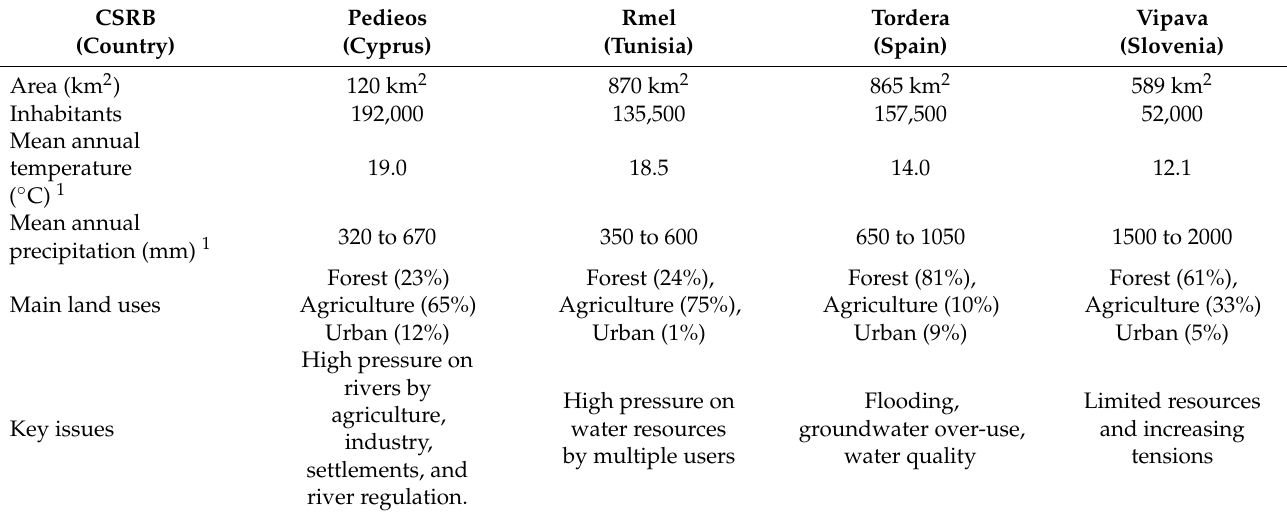
Table 1. Characteristics of the four case study river